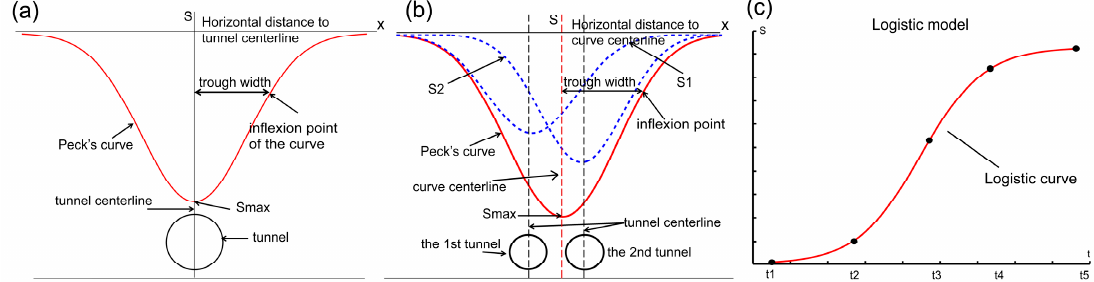
Figure 9. Peck’s curve and the logistic time curve. ( a ) Peck’s curve over a single tunnel and ( b ) Peck’s curve over a twin-tunnel. The two dashed lines, S1 and S2, denote the tunneling-induced transverse ground settlement trough, and the red line is considered as the overall effect of S1 and S2; and ( c ) the logistic time line.